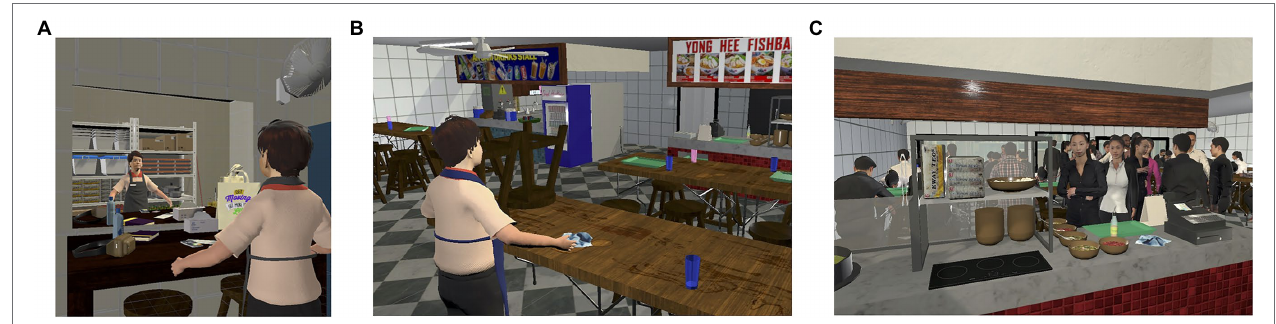
FIGURE 1 | (A) In Scene 1, the participant begins by testing out their visuo-motor synchrony through a mirror in the storeroom. (B) In Scene 2, the participant interacts with the environment by setting up and cleaning the tables outside their stall. (C) In Scenes 3 and 4, the participant starts serving customers who enter the food